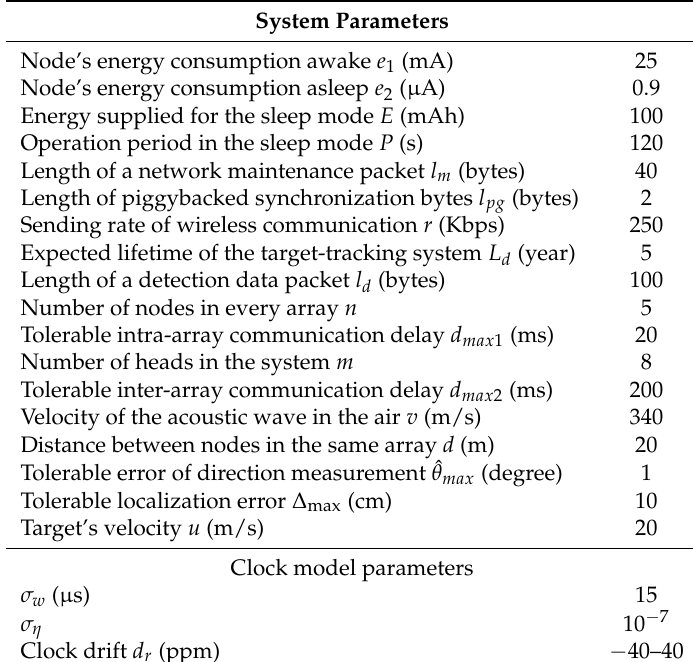
Table 1. System constants and simulation